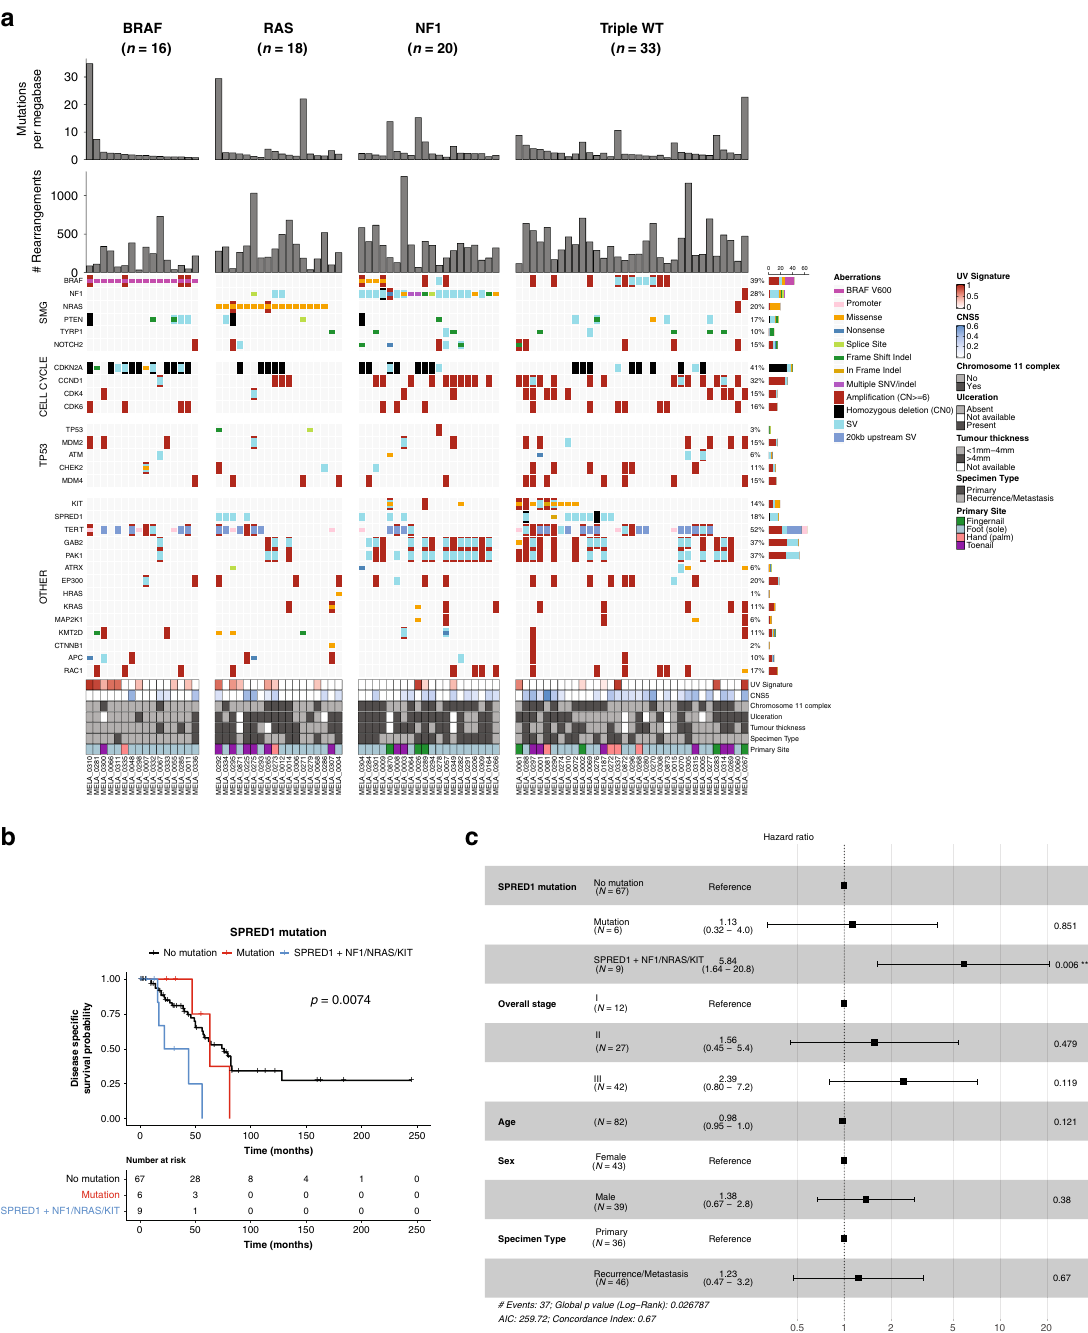
Fig. 6 Acral subclassi fi cations and somatic aberrations in key acral melanoma genes. a Overview of mutations divided by TCGA cutaneous melanoma molecular subclassi fi cations of (left to right): BRAF hotspot (V600) mutated tumors; RAS hotspot mutated tumors; NF1 mutated tumors and Triple wild type (Triple WT). Genes are separated into: signi fi cantly mutated genes (from SNV/indel analysis), TP53, and cell cycle pathway genes, with the remaining genes grouped as Other. In the barcharts in the upper panels, each barchart represents data from n = 87 tumors, where each bar represents the number of mutations per megabase or number of rearrangements for a single tumor. b Kaplan – Meier plot of melanoma-speci fi c survival with log-rank test in patients with or without SPRED1 mutations and co-occurring mutations in KIT , NRAS or NF1 . c Forest plot for a multivariable Cox survival model based on SPRED1 mutations, overall stage, patient age at primary and markers of immunotherapy response: expression of PD-L1 immunotherapy responders 44 , with a further nine with an (Supplementary Fig. 12c) and the proportion of CD8 + T cells intermediate TMB (6 – 19 mutations/Mb), many of which had (Supplementary Fig. 12d) estimated from immune cell deconvo- speci fi c mutational signatures associated: UVR, MMR, SBS32 and lution using CIBERSORT were variable across the cohort. Of the SBS17. In tumors with matching RNA-seq ( n = 63), the number TMB-high tumors, all were above the median. Therefore a subset of expressed neoantigens was signi fi cantly associated with higher of AM may be more likely to respond to immunotherapy. TMB (Supplementary Fig. 12a, Supplementary Fig. 12b). Other